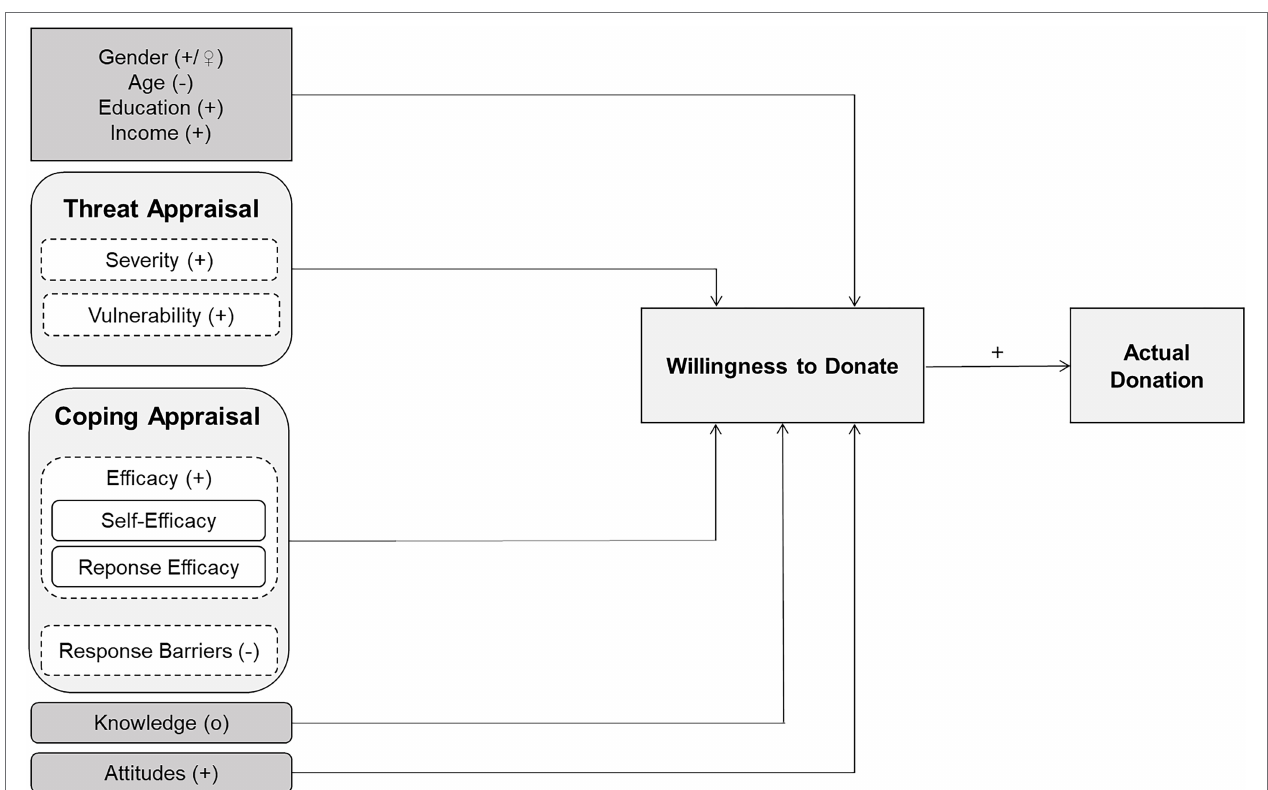
FIGURE 1 | Extended model of the Protection Motivation Theory (PMT) to explain the willingness to donate and actual donations to insect conservation in Germany. Variables of the PMT are colored in light grey. Self-efficacy and response efficacy were summarized as efficacy in this study. Extensions of the PMT are marked in dark gray (gender, age, education, income, knowledge, and attitudes). Latent variables are represented in round boxes and manifest variables are in square boxes. For the sake of clarity, the influences on the actual donations are not shown. It is assumed that the predictors have the same influence on them as on the willingness to donate. Only for attitudes no influence on actual donations is expected. + = positive influence, − = negative influence, o = no